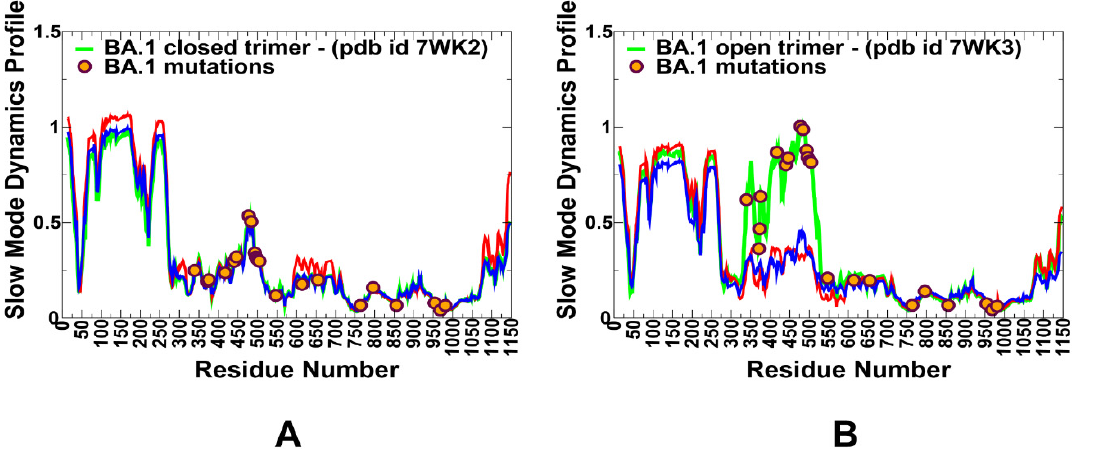
Figure 4. The slow mode mobility pro fi les of the SARS-CoV-2 S Omicron trimer structures. The slow mode dynamics profiles represent the displacements along slow mode eigenvectors and correspond to the slowest 10 modes. ( A ) The slow mode mobility pro fi les for the closed S Omicron BA.1 closed trimer structure (pdb id 7WK2). ( B ) The slow mode mobility profiles for the 1RBD-up open S Omicron BA.1 trimer structure (pdb id 7WK3). The slow mode pro fi les for protomer chains A, B, and C are shown in green, red, and blue lines, respectively. The positions of Omicron BA.1 mutational sites G339D, S371L, S373P, S375F, K417N, N440K, G446S, S477N, T478K, E484A, Q493R, G496S, Q498R, N501Y, Y505H, T547K, D614G, H655Y, N679K, P681H, N764K, D796Y, N856K, Q954H, N969K, and L981F are shown in orange-colored fi lled circles.